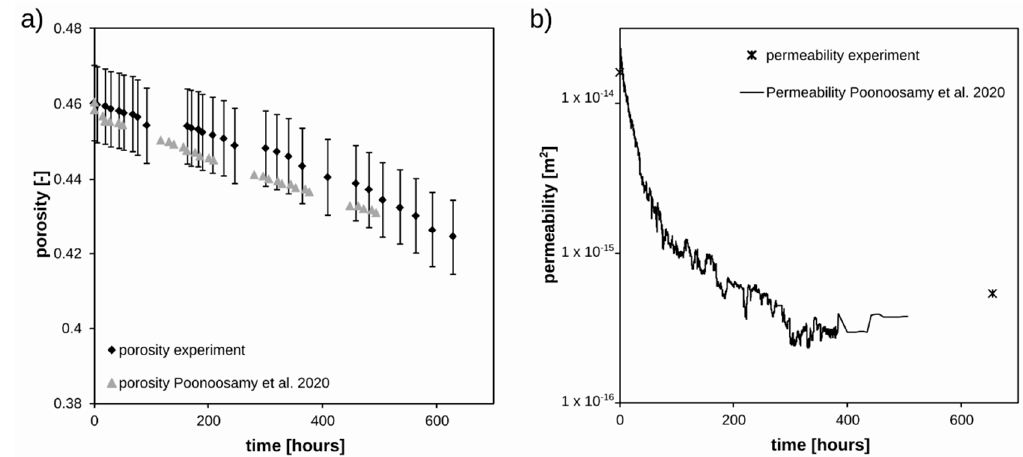
Figure 5. ( a ) Calculated porosity, and ( b ) measured permeability in the celestine layer during the experiment. The measured porosity and permeability changes obtained by Poonoosamy et al. for similar boundary conditions are provided for comparison [16].